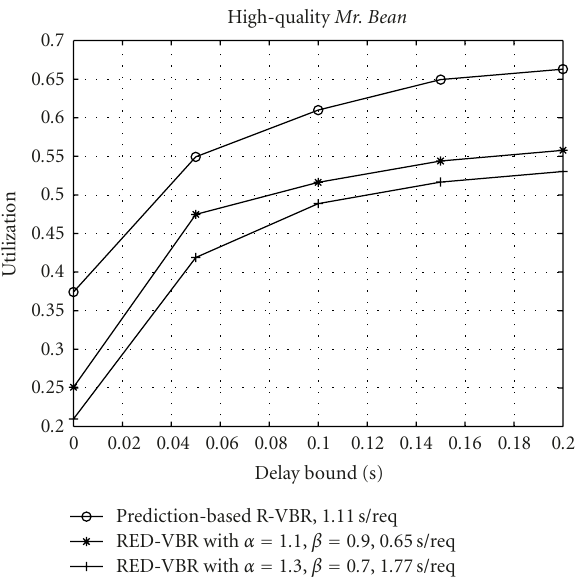
Figure 4: Comparison between online prediction-based R-VBR scheme and RED-VBR scheme for Mr. Bean